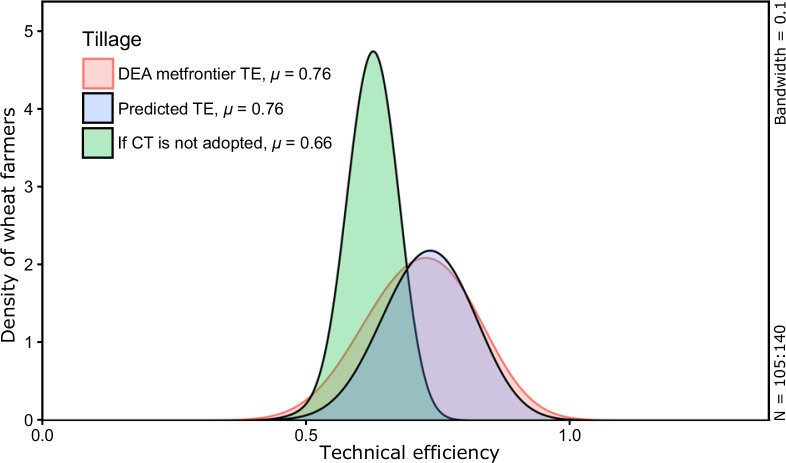
Counterfactual effect of farmers using traditional tillage (CT). The
density curves with red outer line and pink shaded area shows
estimated bias corrected meta-frontier TE from DEA, while the curve
with black outer line and blue shaded area shows the predicted TE
from endogenous switching regression. The curve with black outer
line and green shaded area presents the TE of CT farmers under a
hypothetical scenario if they would have disadopted
the CT practice (color figure online)